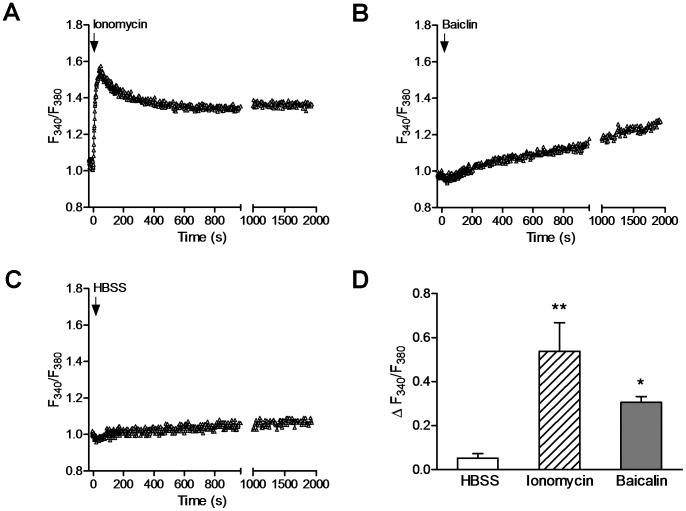
Baicalin increases the intracellular Ca2+ levels in HepG2 cells.Traces show the increases in intracellular Ca2+ levels in response to application of ionomycin (A) and baicalin (B), as well as application of HBSS solution (C) in HepG2 cells loaded with Ca2+ indicator fura 2-AM. Intracellular Ca2+ levels were estimated as the ratio of the signals (F340/F380). (D) Histogram summarizes the changes of intracellular Ca2+ levels (ΔF340/F380) measured after application of HBSS (open bars, n = 3), ionomycin (peak values, hatched bars, n = 3), and baicalin (solid bars, n = 3). * p<0.05 and ** p<0.01 compared to HBSS control.